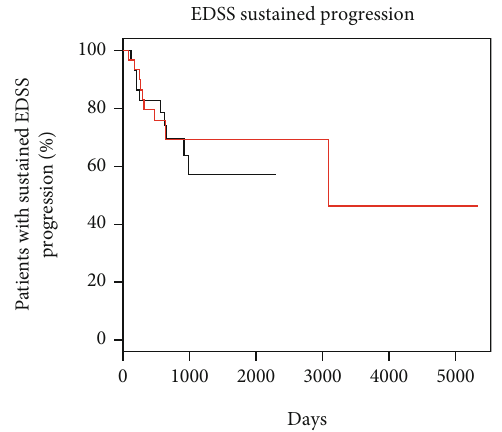
Figure 2: Kaplan-Meier curve for the time to sustained expanded disability status scale (EDSS) progression. Red line represents glatiramer acetate; black line represents teri fl unomide. y -axis is the probability of remaining free of sustained progression on EDSS, and the x -axis is the days since treatment initiation.